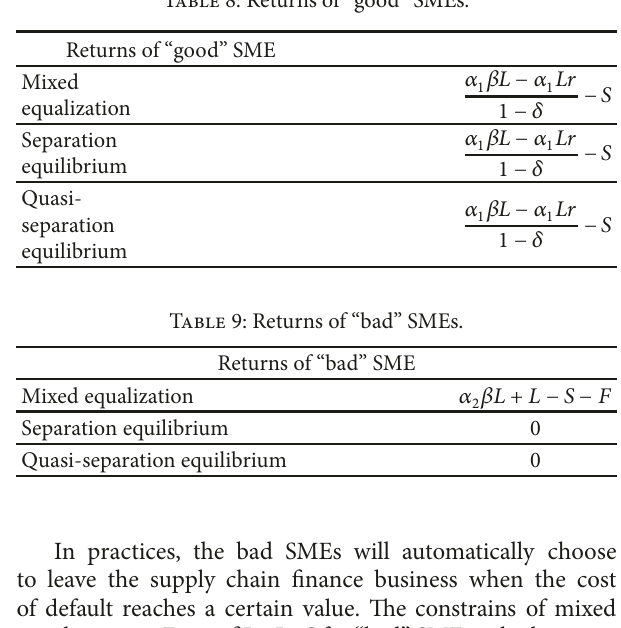
Table 5: The effect of 𝜃 on 𝑚 2 .